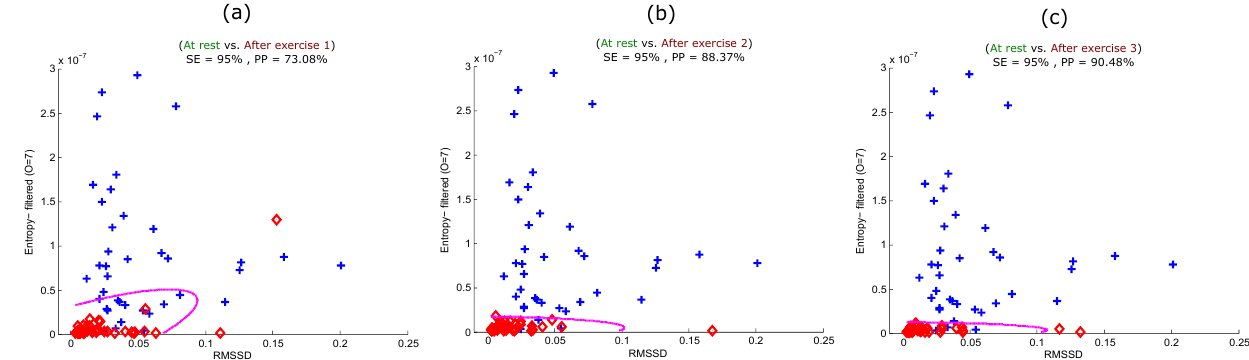
59.68%(At rest vs. After exercise 2) SE = 92.5% , PP =